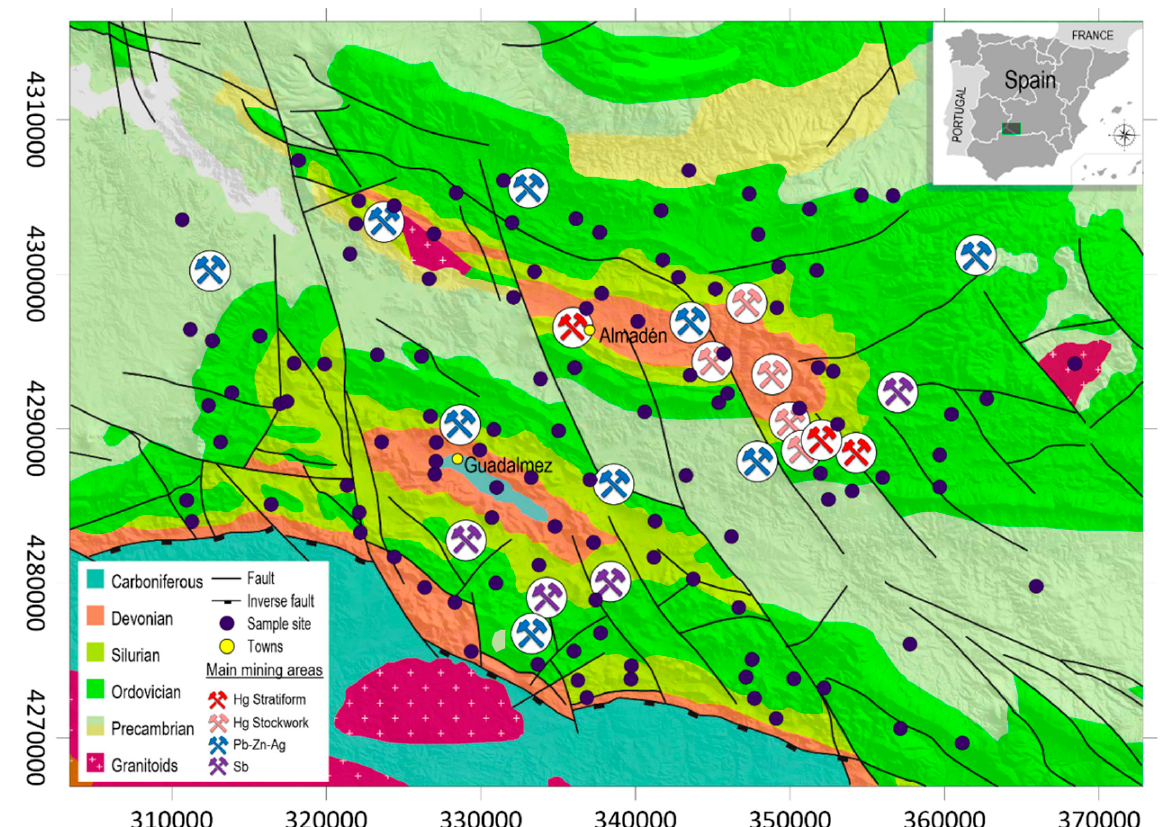
Figure 1. Sampling network in the syncline areas with a geological scheme.